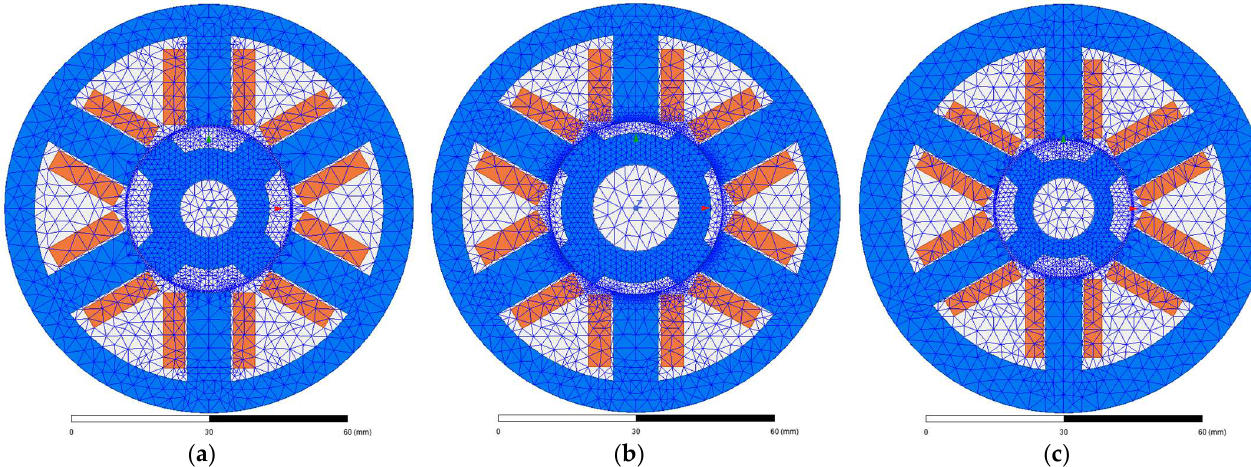
Figure 2. Finite element model from Ansys—Maxwell 2D: ( a ) initial design—before optimization; ( b ) basic design—after several optimizations; ( c ) final design—after optimization, and without a sleeve. The individual colors represent the materials used: blue—sheet material; orange—winding material; white—air.